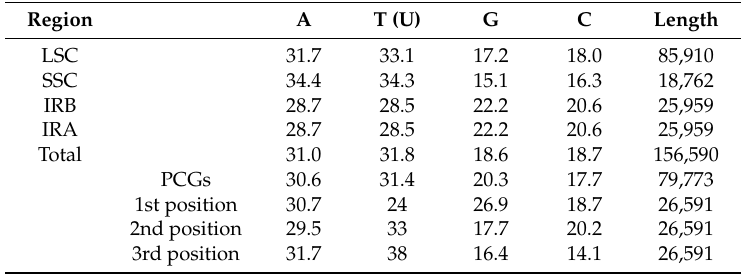
Table 1. Base composition in the chloroplast genome of Rosa chinensis var. spontanea.